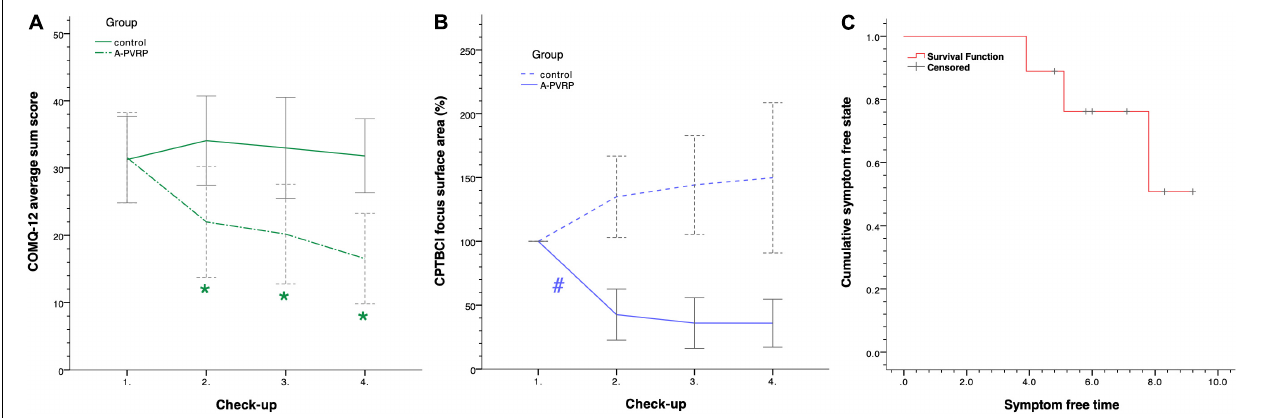
FIGURE 4 | Treatment outcome and symptoms at follow-up. (A) COMQ-12 average sum scores (Vozel et al., 2020a); (B) CPTBCI focus area percentages; (C) Kaplan–Meier curve. 95% CIs are included in graphs (A,B) . Graph (C) is based on the data of 9 of 11 (82%) patients treated with PVRP who were symptom-free after the fourth checkup of the trial. Cumulatively, 49% of patients from the PVRP group remained symptom-free for 12.7 months after the fourth checkup. COMQ-12: chronic otitis media questionnaire 12; CPTBCI: chronic postoperative temporal bone cavity inflammation; PVRP: platelet- and extracellular vesicle-rich plasma; *statistically significant difference between groups within checkup; #statistically significant difference between the first and second checkups in the PVRP group.